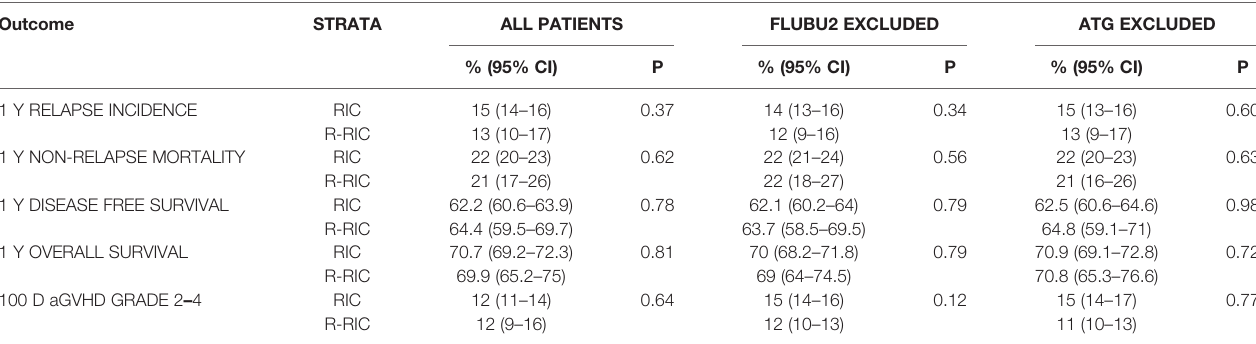
TABLE 2 | Transplant outcomes for entire cohort, patients excluding those receiving fl udarabine plus busulfan, and patients excluding those receiving anti-T-cell globulin. Outcome STRATA ALL PATIENTS